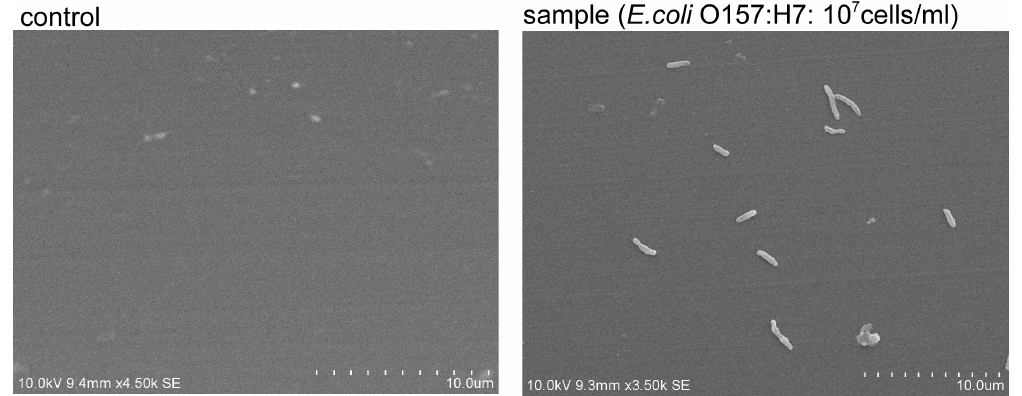
Figure 3. SEM images of optical fibers with captured E. coli O157:H7 cells. E. coli O157:H7 binding was examined on the aspect of the optical fiber. The left (control) is without capture antibody, and the right (sample) is with goat polyclonal capture antibody.